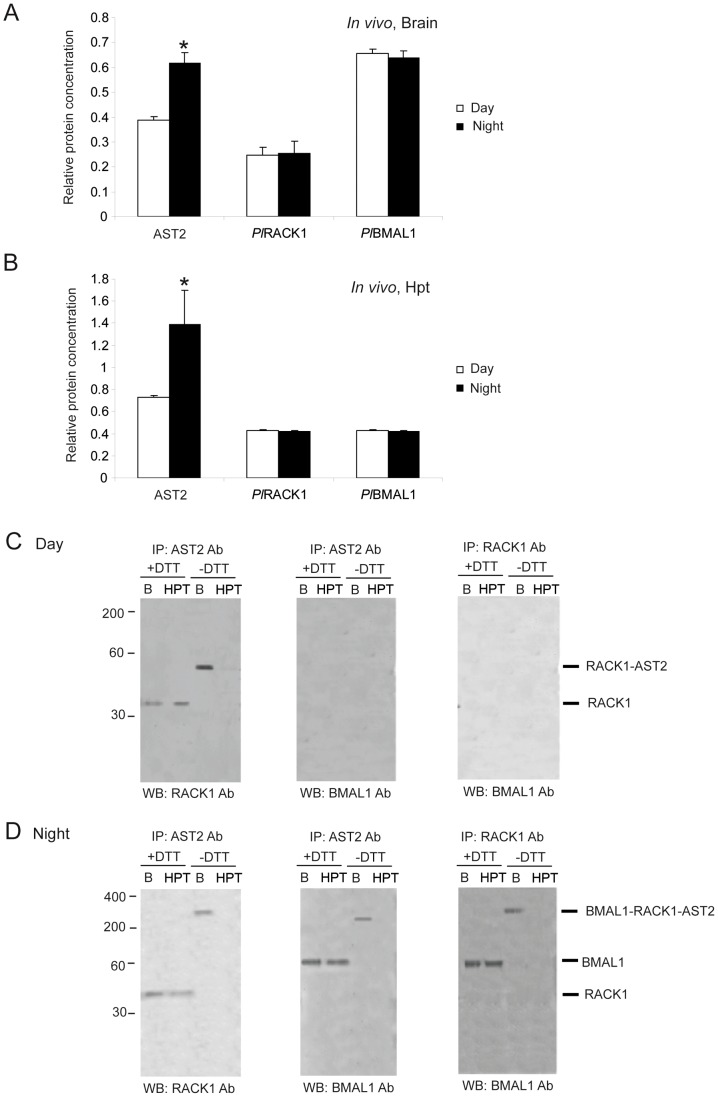

PlRACK1, PlBMAL1, and AST2 form an approximately 200-kDa protein complex during the dark period.A) Relative amounts of AST2, PlRACK1 and PlBMAL1 proteins in brain extracts as determined by ELISA at 3 h after light turned off or on. B) Relative amounts of AST2, PlRACK1 and PlBMAL1 proteins in HPT extracts as determined by ELISA at 3 h after light turned off or on. The asterisks indicate significant differences (*P<0.05); one-way ANOVA with Duncan's new multiple-range test and the Tukey test. Results are representative of three independent experiments. Error bars indicate SD from three replicates and the experiment has been repeated three times with similar results. C) Immunoprecipitation (IP) of brain extract using antibodies against RACK1, BMAL1 and AST2 revealed that a PlRACK1-AST2 complex was present in the brain (B) during the day. D) Immunoprecipitation (IP) of brain extract using antibodies against RACK1, BMAL1 and AST2 revealed the presence of a high-molecular-weight complex (approximately 200 kDa) composed of all three proteins in the brain (B) at night. C–D) The immunoprecipitated complex was analyzed by western blotting (WB) using another antibody. “B” and “HPT” represent brain and hematopoietic tissue, respectively. The antibodies used for immunoprecipitation (IP) and detection (WB) is indicated at the top and bottom of the blots, respectively, and +DTT and −DTT represent reducing and non-reducing conditions, respectively. Molecular masses are indicated at the left.